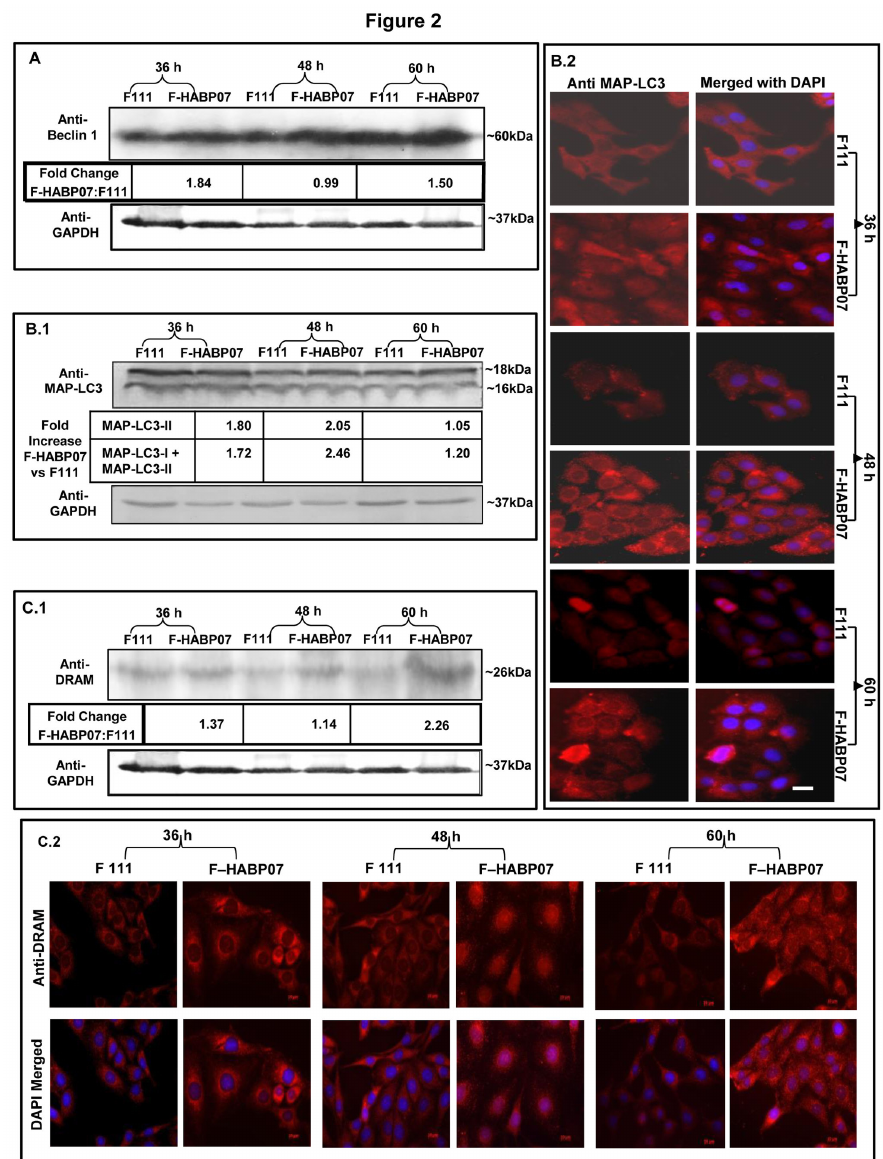
Figure 2. Detection of autophagic markers by immunoblotting and immunocytochemistry. [A] Elevated expression of the autophagic marker Beclin 1 upon overexpression of HABP1 in fibroblasts -- Whole cell lysates of F111 and F-HABP07 grown for 36, 48 and 60 h were subjected to immunoblot analysis, using antibody against the autophagy modulator, polyclonal Beclin 1 (1:1000) and monoclonal anti-GAPDH (1:20000) as control. Upon normalization of expression of Beclin 1 against GAPDH, Beclin 1 was found to be much higher in F-HABP07 at 36 and 60 h of growth, but it reduces at 48 h of growth to almost basal level. [B] Elevated expression of the autophagic marker MAP-LC3 upon overexpression of HABP1 in fibroblasts -- Immunoblot analysis confirming a higher expression of the autophagic marker MAP-LC3-II at 48 h of growth in F-HABP07 as compared to F111 ( B .1) after normalization of MAP-LC3-II expression with GAPDH expression. Upsurge in MAP-LC3 expression in HABP1 overexpressing fibroblasts, F-HABP07 compared to F111 (grown for 36, 48 and 60 h) was observed upon visualization under Fluorescence microscope after immunocytochemical analysis performed using MAP-LC3 antibody (1:200), reprobing with anti-rabbit Alexa Fluor 546 and DAPI for staining the nucleus ( B .2). Scale=10µ. [C] Increased expression of autophagic modulator DRAM -- Immunoblotting with antibody against the lysosomal protein DRAM, which is transactivated by p53 and normalization with GAPDH by the help of ImageJ. The fold increase calculated for each time point (F-HABP07 versus F111) indicates that the expression level of DRAM was higher at 36 and highest at 60 h of growth ( C .1). Similar expression and nuclear translocation in F-HABP07 cells was also observed after immunocytochemical analysis ( C .2). doi: 10.1371/journal.pone.0078131.g002 PLOS ONE |